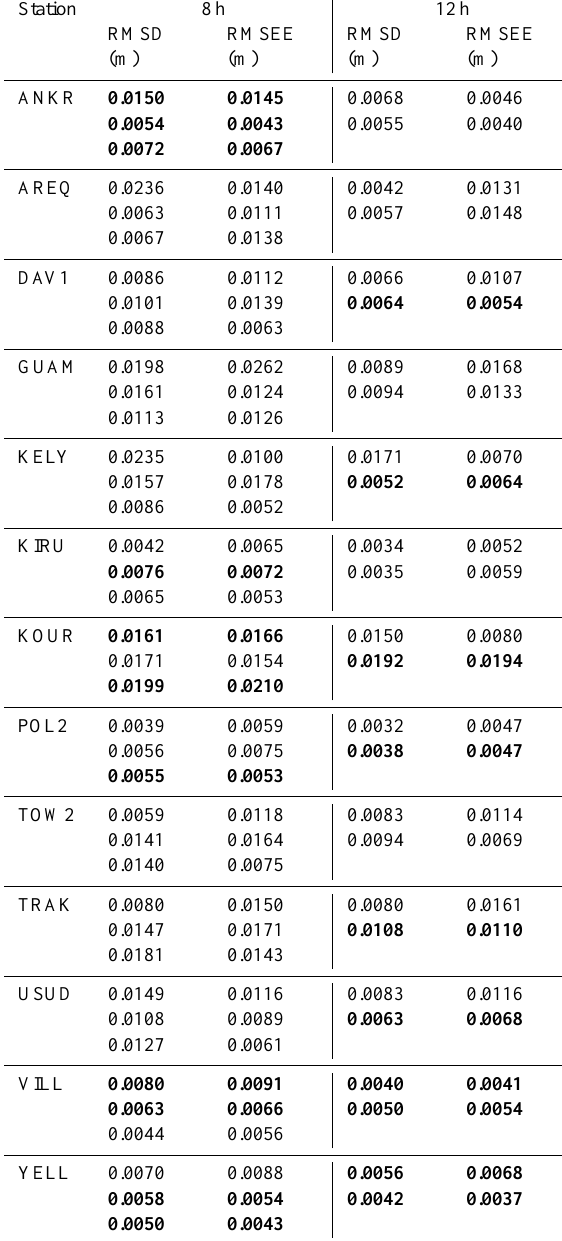
Table 8. Testing whether RMSEEs from individual vertical short session regression models are identical to RMSDs formed using 24h solutions as the truth (1mm threshold is used). The identical solutions are shown with bold